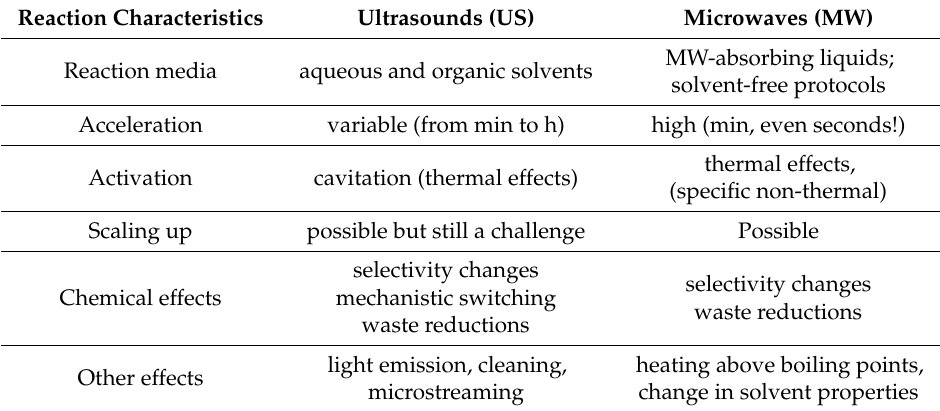
Table 4. Ultrasounds versus microwave.